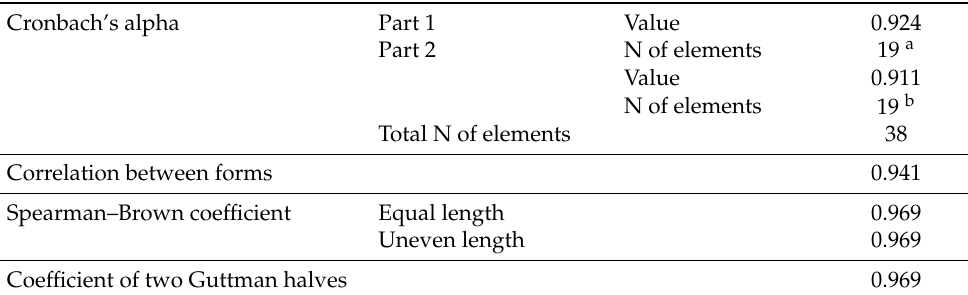
Table 1. Half-and-half method reliability statistics. Cronbach’s alpha